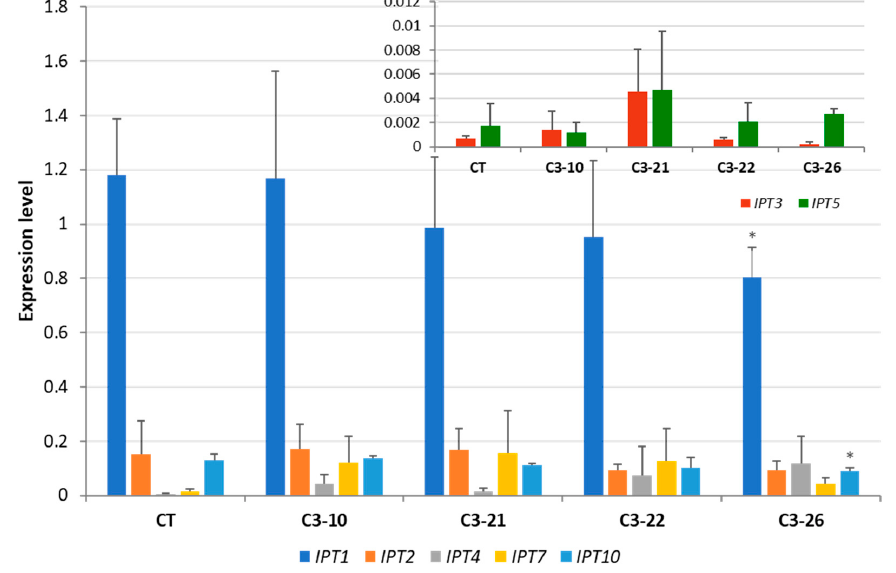
Figure 6. Expression of HvIPT genes in seven DAP spikes of ckx3 mutant lines; expression of HvIPT3 and HvIPT5 and was shown on a separate graph because of lower expression levels. CT, control plants; values are mean ± SD (Table S9) * significantly di ff erent from control at p < 0.05. The expression levels were calculated from three technical replicates according to the standard curve methods using the Elongation factor 2 gene as a normalizer. The analysis was performed for three biological